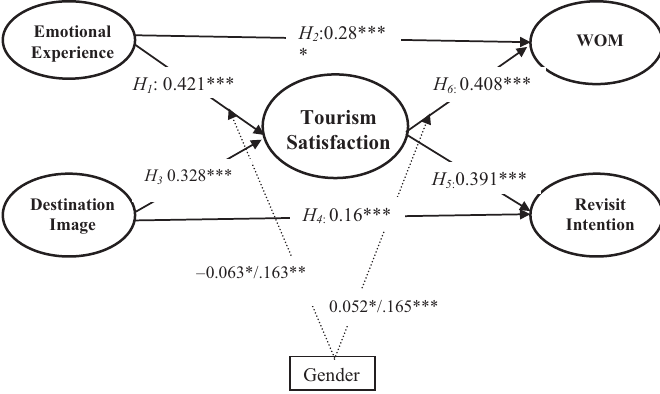
Figure 2. Results of hypotheses test